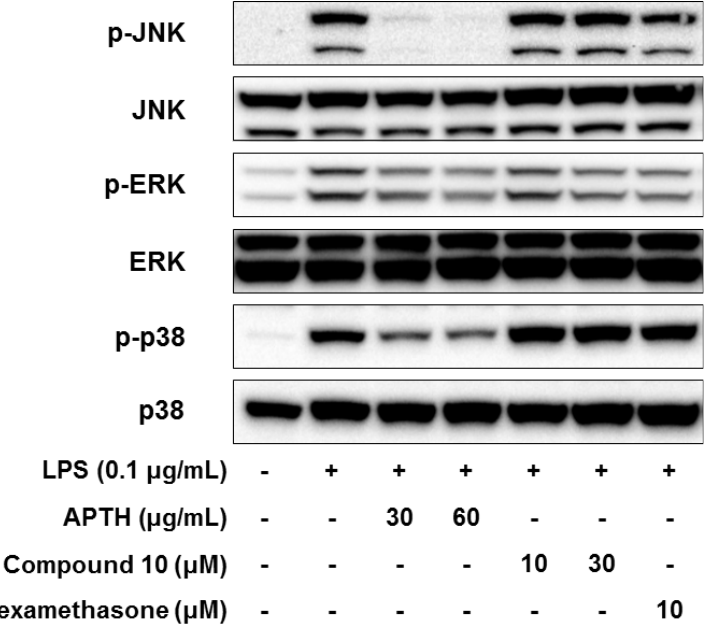
Figure 5. Effects of APTH and compound 10 on JNK, ERK, and p38 MAPK phosphorylation in LPS-stimulated RAW264.7 cells. Cells were pretreated for 1 h in the presence or absence of samples and then treated for 0.5 h with LPS (0.1 μg/mL). The phosphorylation of the JNK, ERK, and p38 proteins was measured by Western blotting, and total JNK, ERK, and p38 protein levels were used as loading controls. Dexamethasone served as the positive control.